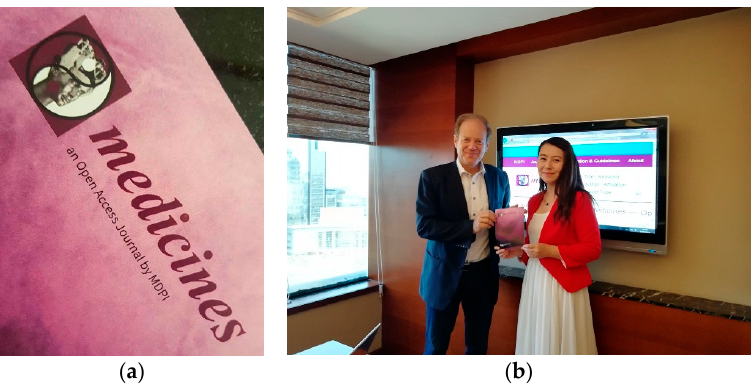
Figure 25. ( a ) Medicines journal flyer; ( b ) Professor Gerhard Litscher: Editor-in-chief of Medicines and